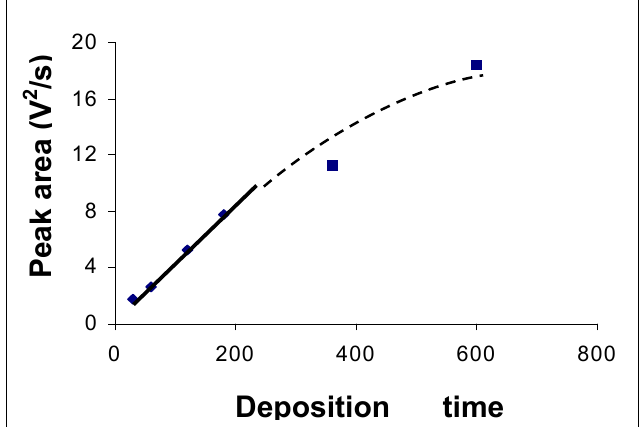
Figure 5 . Influence of the electrolysis deposition time of mercury on the gold electrode surface on the registered analytical signal. Concentration of mercury solution was 50 μ